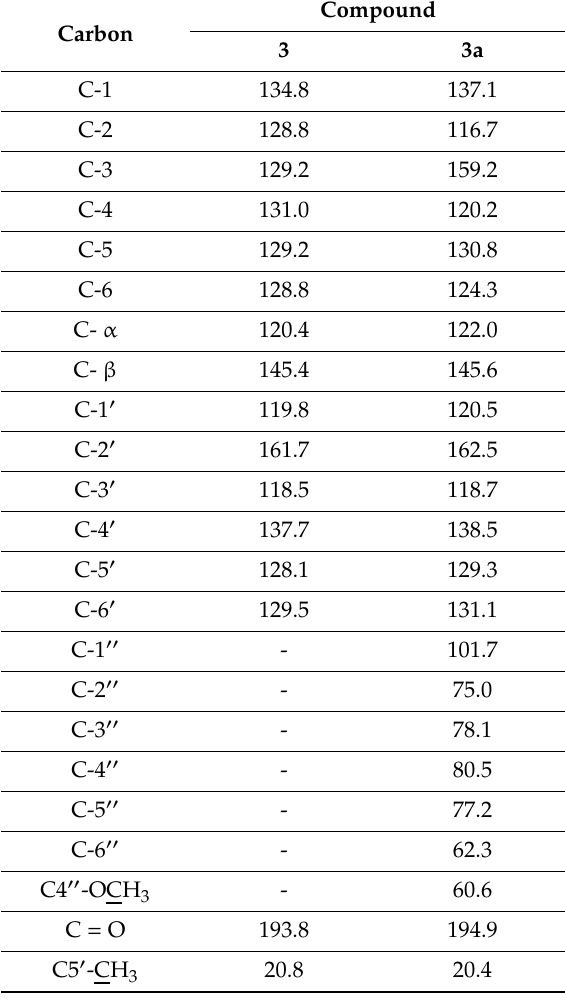
Table 2. 13 C-NMR chemical shifts δ (ppm) of 2 (cid:48) -hydroxy-5 (cid:48) -methylchalcone ( 3 ) in Chloroform-d, and product of its biotransformation 3a in Acetone-d6, 151 MHz (Supplementary